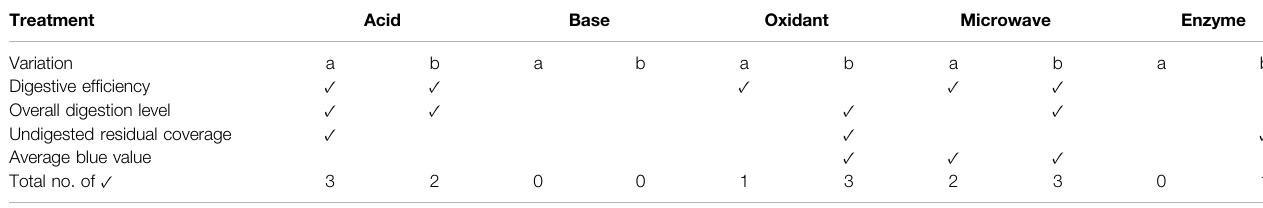
TABLE 1 | Summary of gravimetric and image analysis results in an evaluation matrix, where a tick ( ✓ ) indicates that the cut-off criteria is met. Treatment Acid